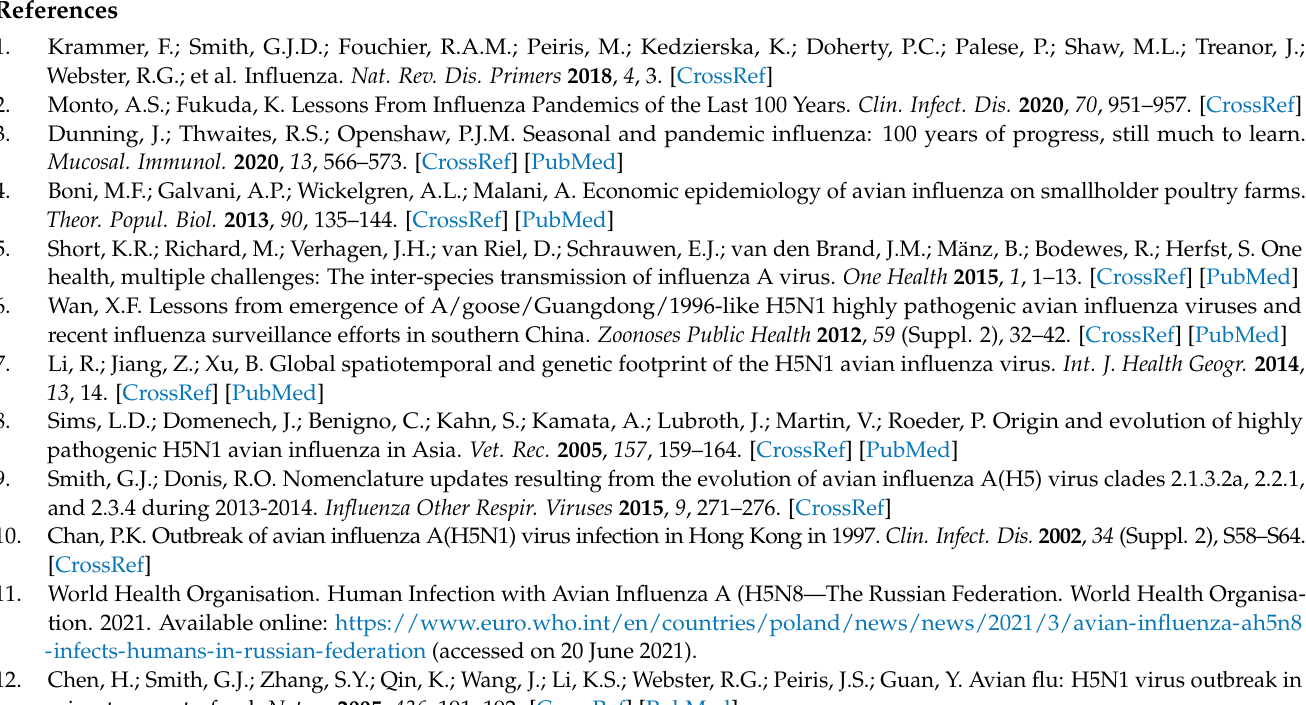
Figure S4: Correlation between the number of H5N1 and H5N8 positive samples in Egypt. Table S1. Positive cases of H5N1 and H5N8 in Egypt by sectors and